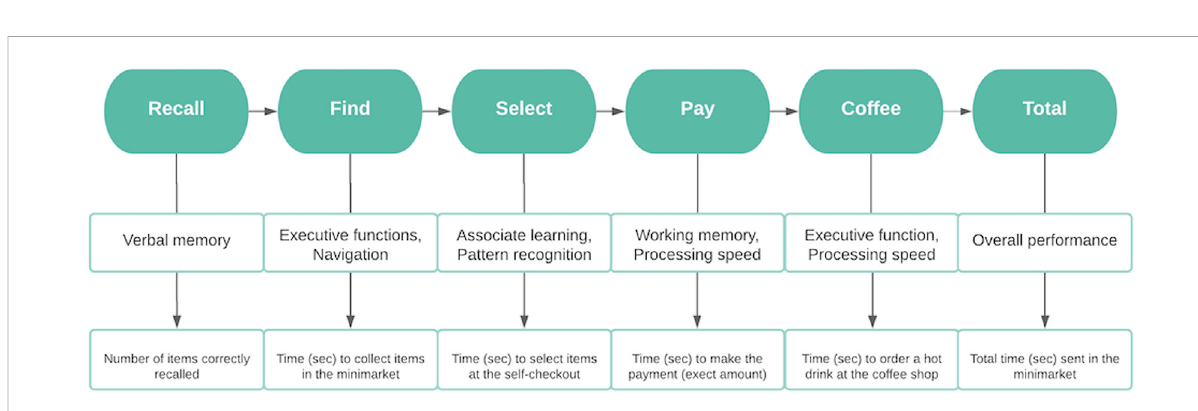
FIGURE 4 Flowchart depicting the steps required to complete VStore, its corresponding cognitive domains, and outcome variables. © Porffy et al. (2022). Originally published in the Journal of Medical Internet Research (https://www.jmir.org), 26.01.2022. This is an open-access article distributed